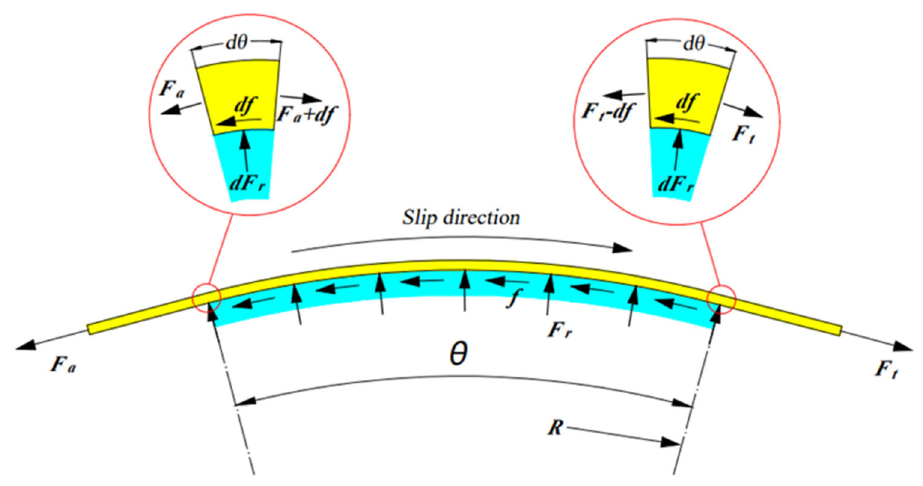
Figure 13. Sketch of model calculation for the tensioning stage. The prestressed CFRP tendons were differentiated and divided into countless equal arcs according to the angle of the arc occupied, the angle occupied by each equal arc was d θ , and the friction force generated by the arc was df .